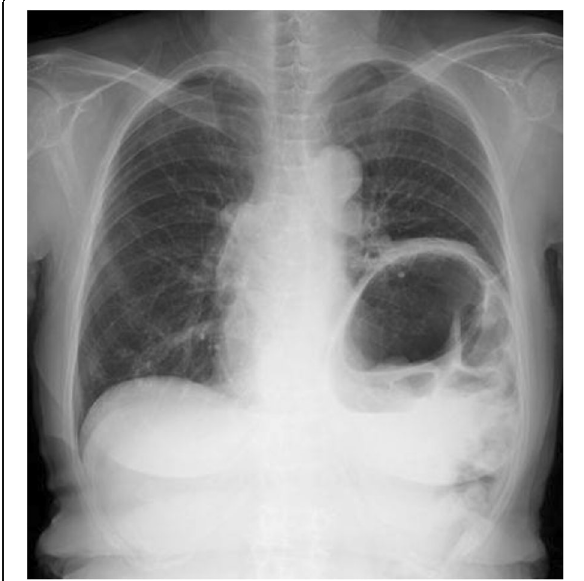
Fig. 2 Chest X-ray before diaphragm plication. The left diaphragm was elevated before